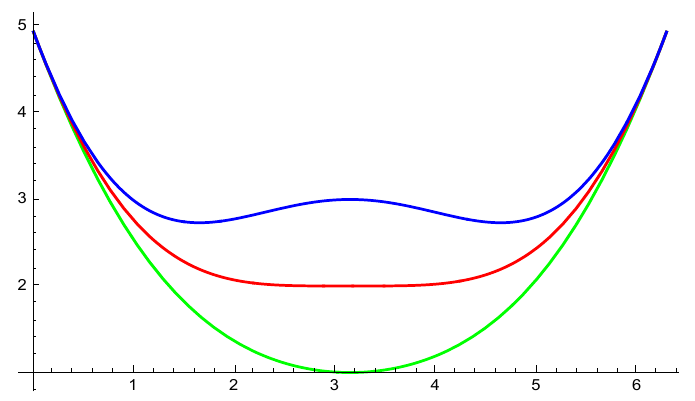
Figure 2 . V ( (cid:30) ) of eq. (3.1) at (cid:18) = (cid:25) , and (cid:15) = 0 : 5 (green curve), (cid:15) = 1 : 0 (red) and (cid:15) = 2 : 0 (blue). For (cid:18) = (cid:25) there is always a stationary point at (cid:30) = (cid:25) which, however, for the case (cid:15) > 1, corresponds to a maximum ( V 00 < 0). Since V is bounded from below there should be minima elsewhere. Indeed, for (cid:15) = 1 + (cid:14); (cid:14) (cid:28) 1, one easily (cid:12)nds two (degenerate) minima. For (cid:15) = 1 the three stationary points degenerate at (cid:30) = (cid:25)